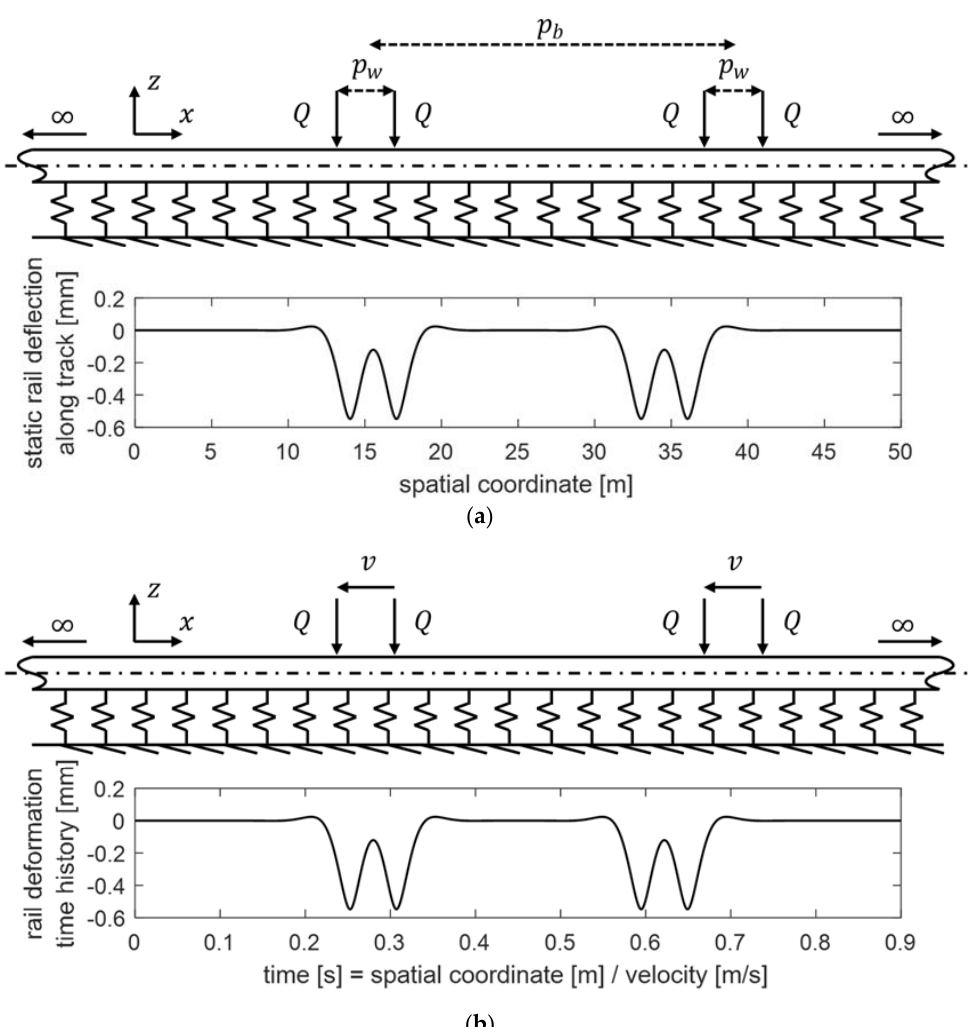
Figure 7. ( a ) Static rail deflection distribution along the track obtained with a Winkler model with the wheelset loads. ( b ) Elastomeric material deformation time history converted from the static rail deformation distribution along the track with a constant train velocity ( v = 200 km/h).